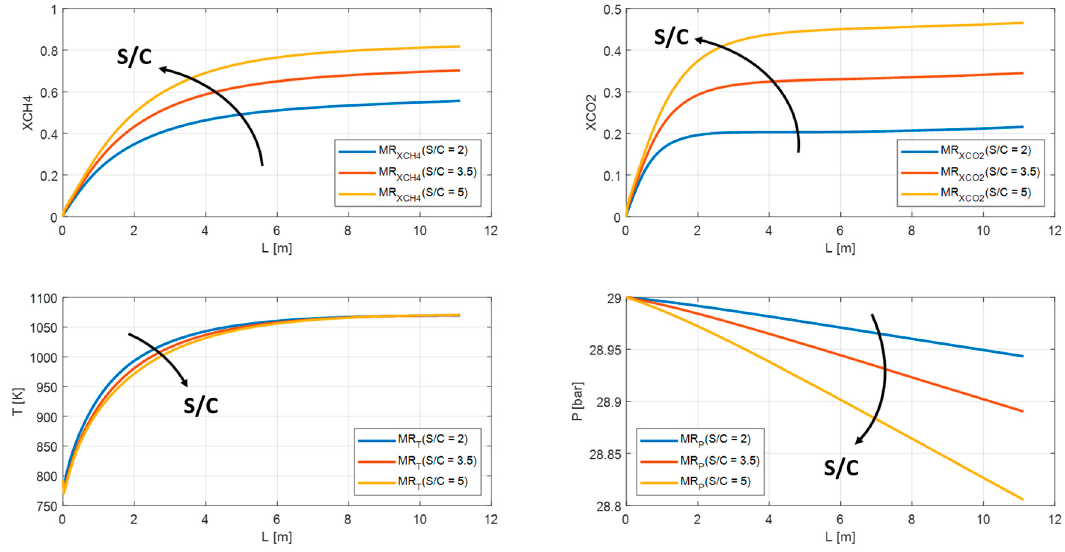
Figure 15. Methane conversion, carbon dioxide yield, temperature, and pressure profile in MR for S/C = 2, S/C = 3.5, S/C = 5.